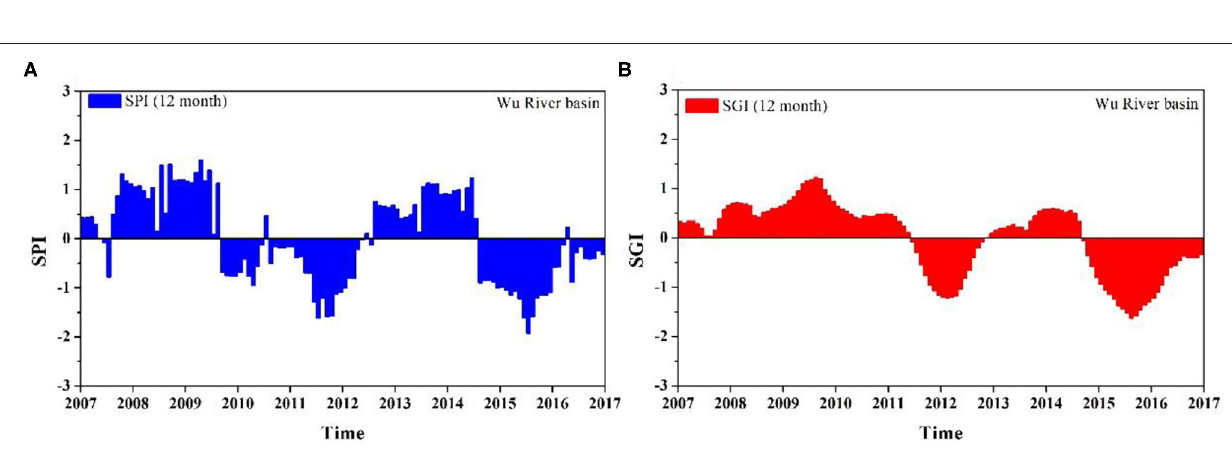
FIGURE 5 | (A,B) Long-term ( q = 12) SPI and SGI analysis results for the Wu River Basin.